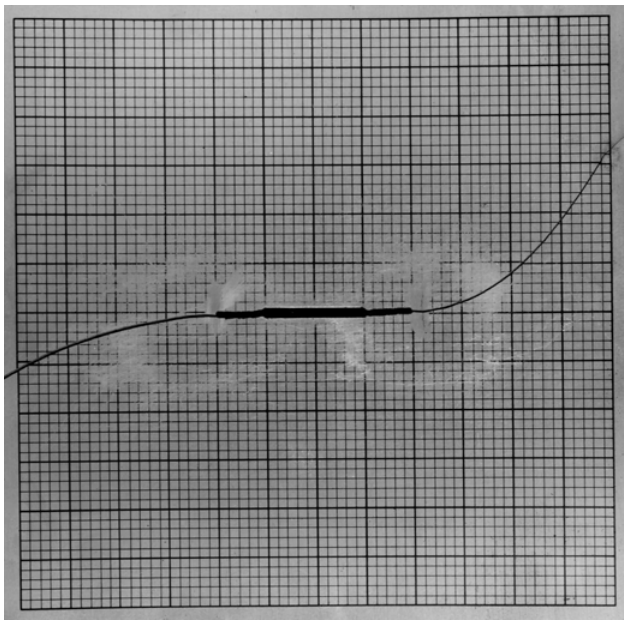
Figure 6. Crack path in a Waspaloy sheet under biaxial fatigue load. The grid is 2.54 mm.